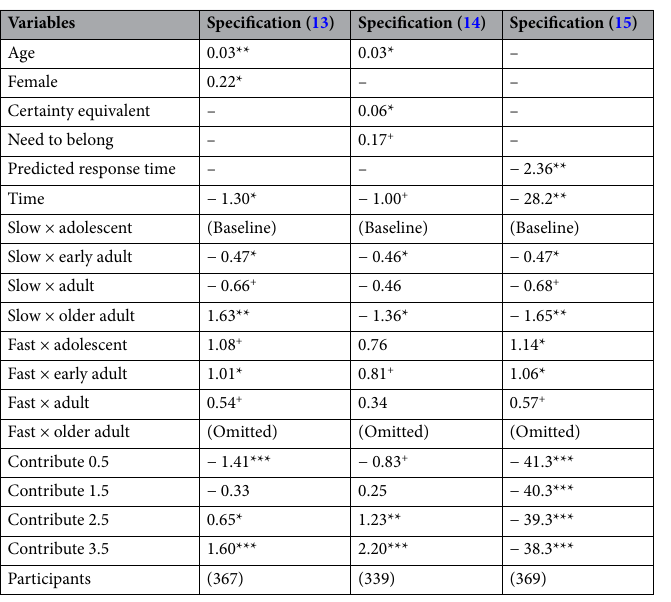
Table 2. Ordered probit estimates of specifications (13), (14), and (15). + p < 0.15 (marginally